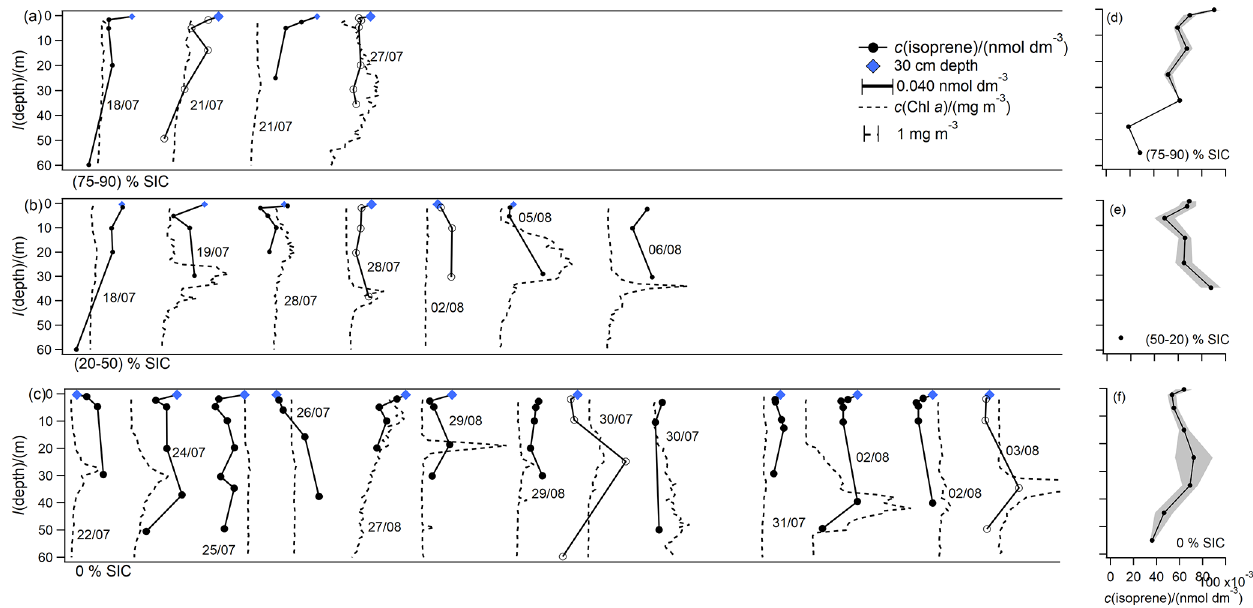
Figure 6. Overview plot displaying the shape of all isoprene and Chl a depth profiles, grouped by SIC and staggered along the x axis for ease of viewing. Panel labels indicate the SIC bin. The scale bars for isoprene and Chl a in (a) also apply to (b) and (c) . Profiles with hollow markers are highlighted in Fig. 7. One of the Chl a profiles is cut off in (c) for scale purposes. Sampling dates are indicated to locate stations using Fig. 1. Panels (d) to (f) indicate absolute concentrations of mean vertical profiles grouped according to ice cover and binned by depth horizons. The shaded area indicates standard error for each depth